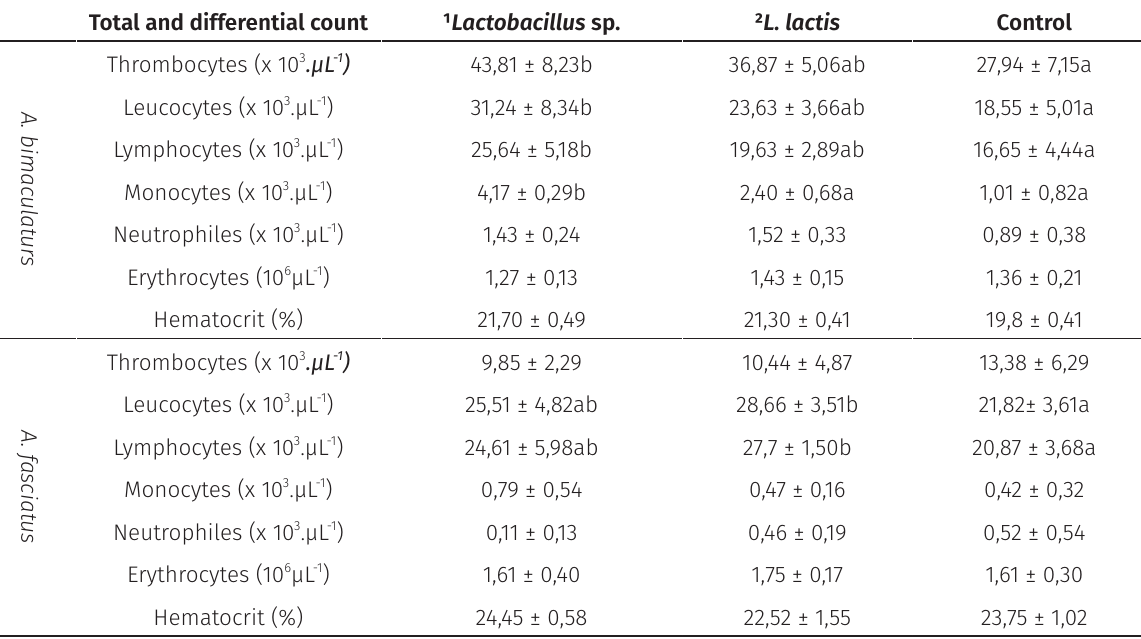
* Different letters indicate significant differences (P<0.05) between treatments in ANOVA and SNK test. ¹Autochthone for A. bimaculatus and allochthone for A. fasciatus . ² Allochthone for A. bimaculatus and autochthone for A. fasciatus